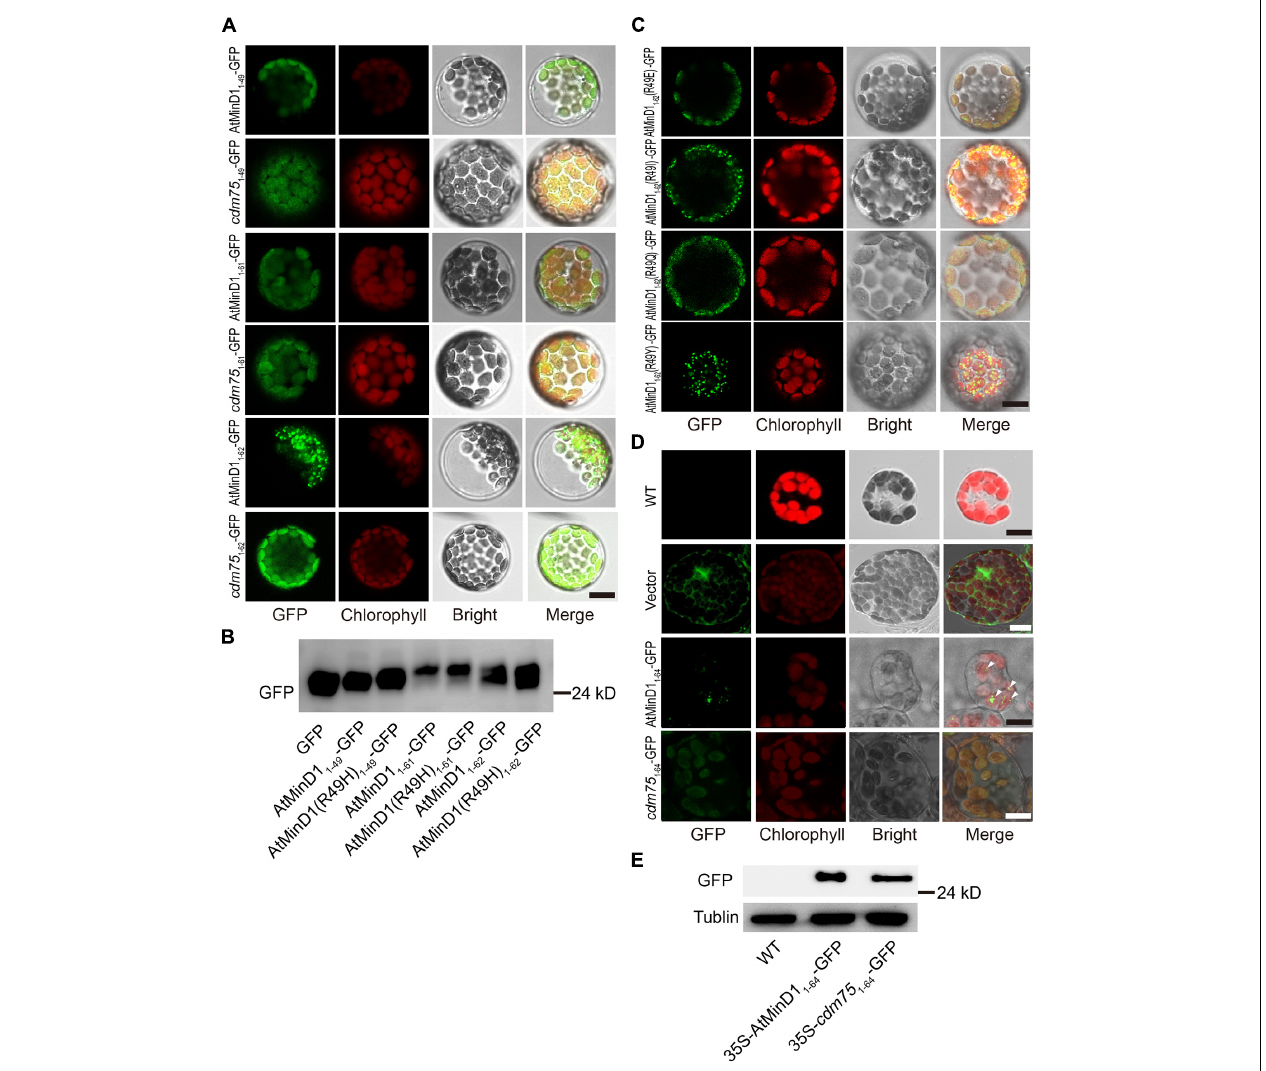
FIGURE 3 | Analyses of the transit peptide and localization of the specific fragment in AtMinD1 with GFP. (A) Fluorescence micrographs showing the different lengths of fragments fused with GFP transiently expressed in Arabidopsis protoplasts, which include AtMinD1 1 − 49 -GFP, cdm75 1 − 49 -GFP, AtMinD1 1 − 61 -GFP, cdm75 1 − 61 -GFP, AtMinD1 1 − 62 -GFP, and cdm75 1 − 62 -GFP. Scale bars = 10 µ m. (B) Total proteins from the transfected protoplasts shown in (A) were extracted for further immunoblotting analysis. Bands on the blots were detected using GFP antibody. (C) Fluorescence micrographs showing the different mutation of residue